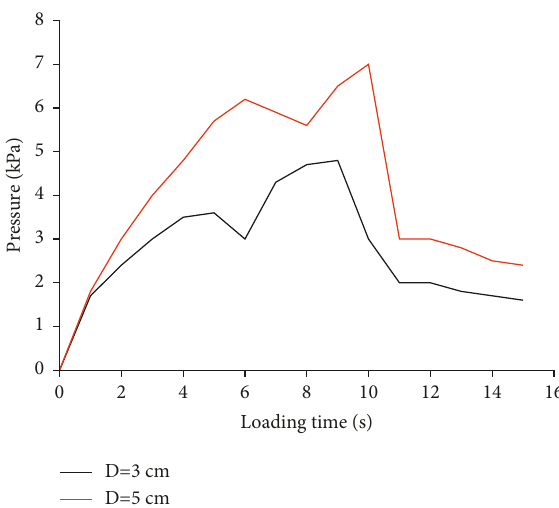
Figure 9: The stress of the anchor plates with different diameters.